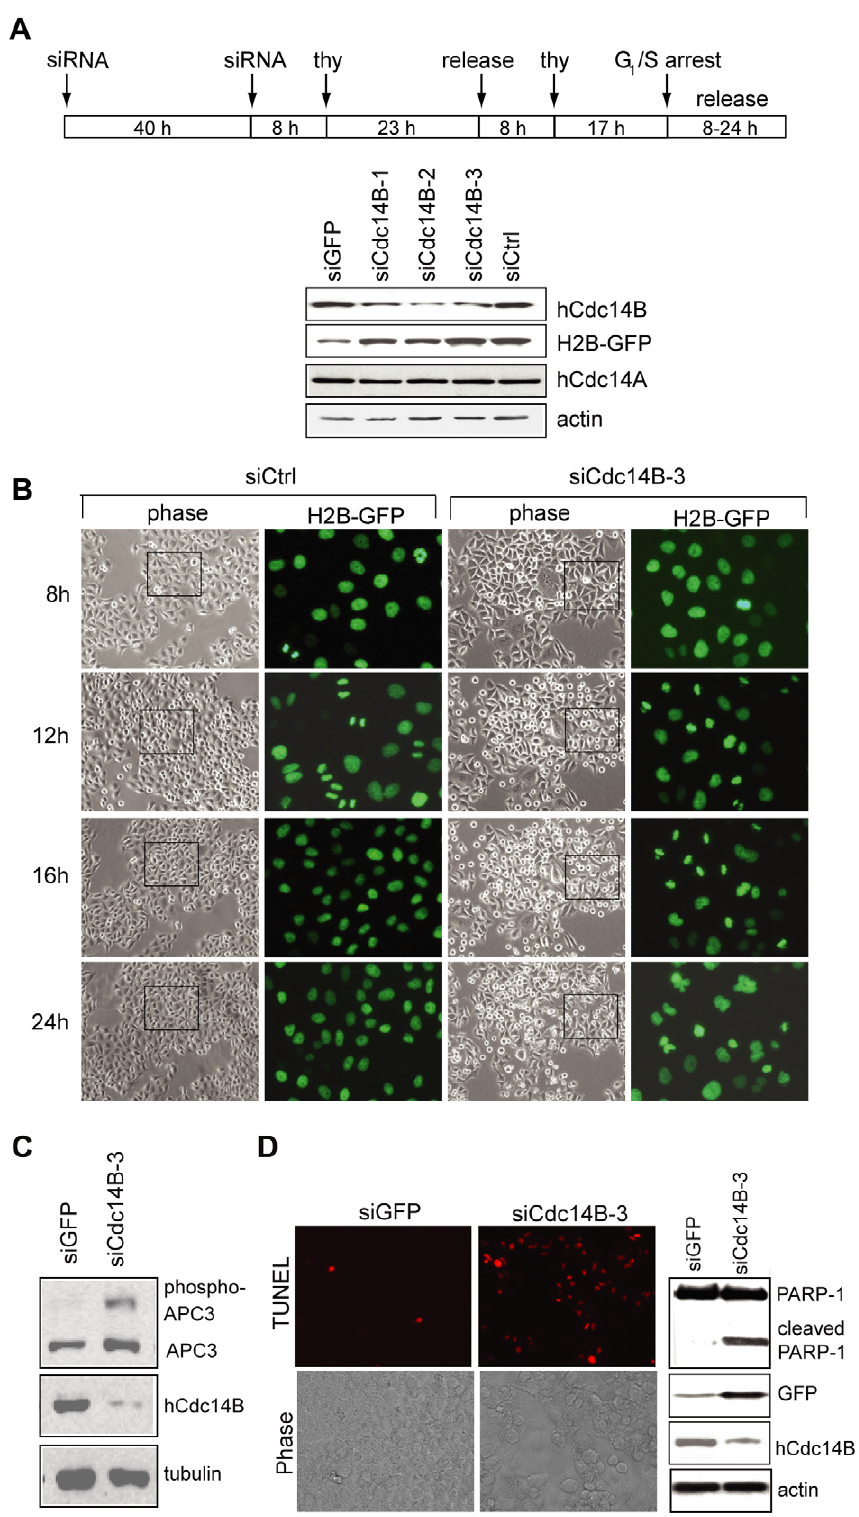
Figure 3. Depletion of hCdc14B impairs progression through mitosis and triggers apoptosis. A . Cell synchronization and specificity of hCdc14B knockdown by siRNAs. HeLa Kyoto cells were reverse transfected with a control siRNA pool (siCtrl), siRNAs that target GFP-mRNA (siGFP), or three different regions of hCdc14B-mRNA (siCdc14B-1, -2, -3; see Table S1 for sequence information) and synchronized as shown in the scheme. 8 h after release from the second G 1 /S arrest, cells were lysed and the amount of hCdc14B, hCdc14A, H2B-GFP, and actin was analyzed on immunoblots. B . Phase contrast and H2B-GFP fluorescence images of HeLa Kyoto cells that were transfected with control-siRNA (siCtrl) or hCdc14B-siRNA (siCdc14B- 3) and released from G 1 /S according to the scheme above. Before the second G 1 /S arrest, equal numbers of cells were seeded onto coverslips. The